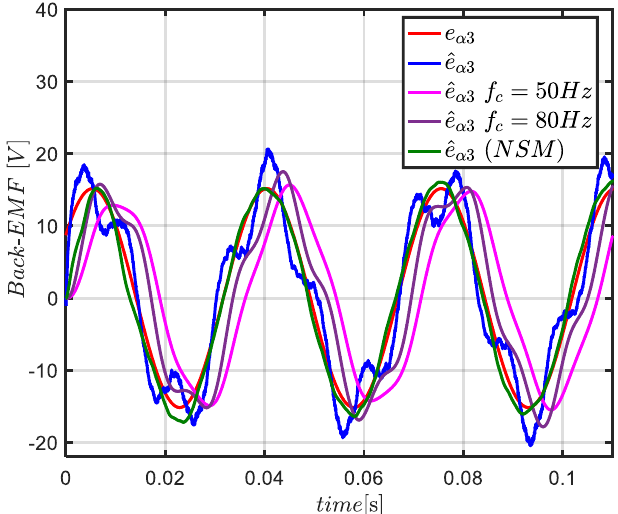
Figure 13. Simulation waveforms of the actual back EMF of the 3rd harmonic and the estimated back EMF through TM in the α -axis using the methods of harmonics separation.